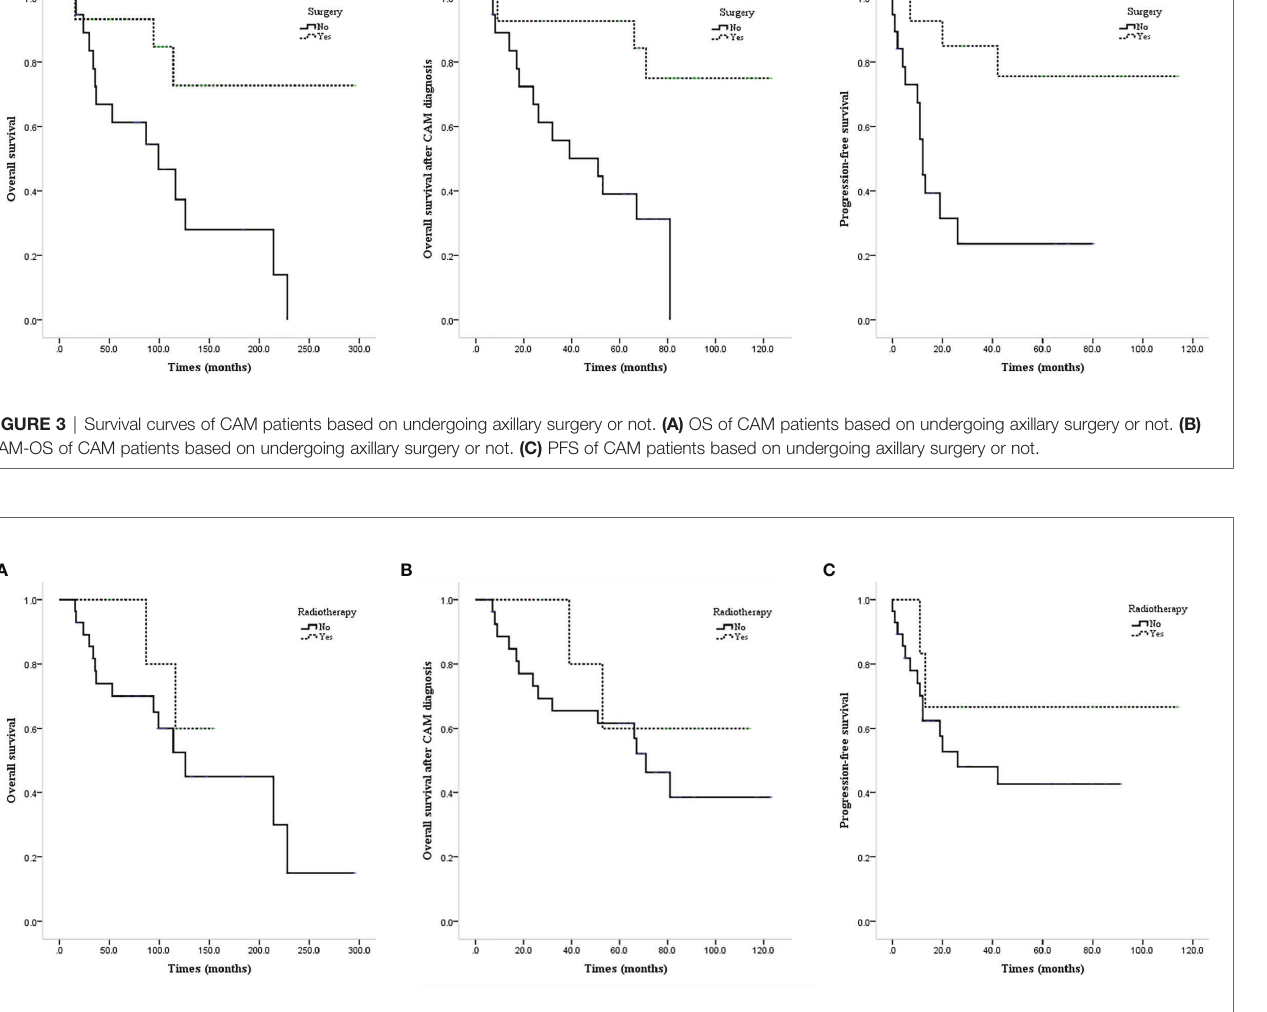
FIGURE 4 | Survival curves of CAM patients based on undergoing axillary radiotherapy or not. (A) OS of CAM patients based on undergoing axillary radiotherapy or not. (B) CAM-OS of CAM patients based on undergoing axillary radiotherapy or not. (C) PFS of CAM patients based on undergoing axillary radiotherapy or